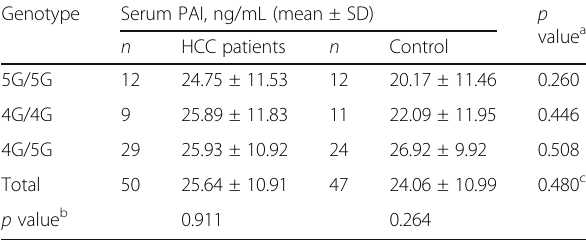
Table 4 Serum levels of PAI-1 in HCC patients and controls